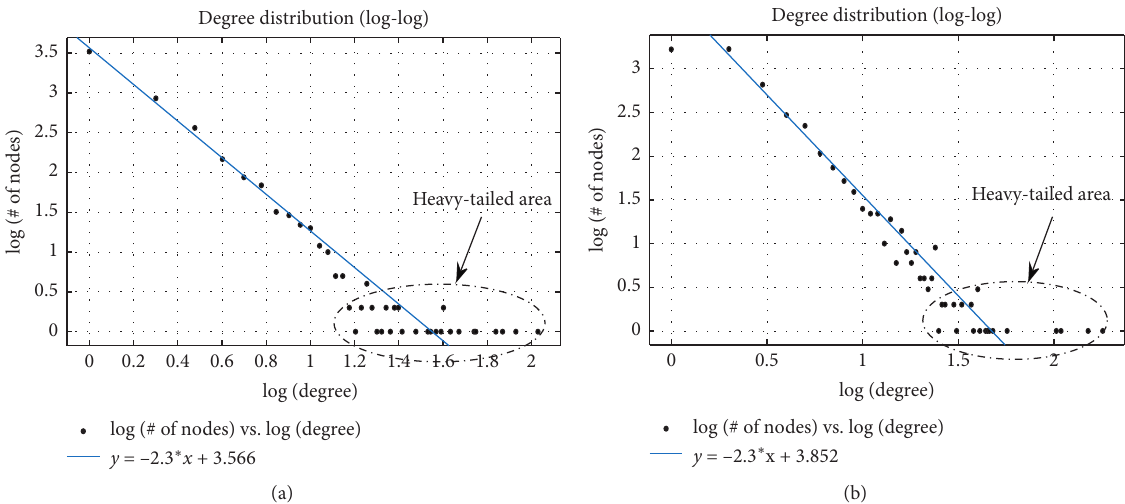
Figure 4: Comparison diagram of scale-free network-degree distribution and network topology degree distribution in this study. (a) Scale- free network-degree distribution. (b) Network topology degree distribution in the study.